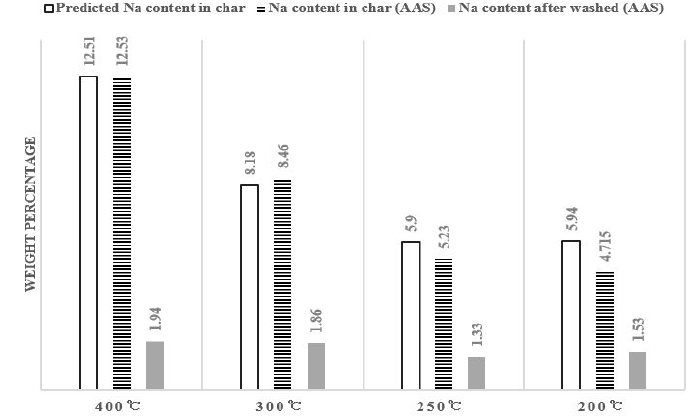
Figure 5. Na content in pyrolysis char (atomic absorption spectrophotometry (AAS) analysis).